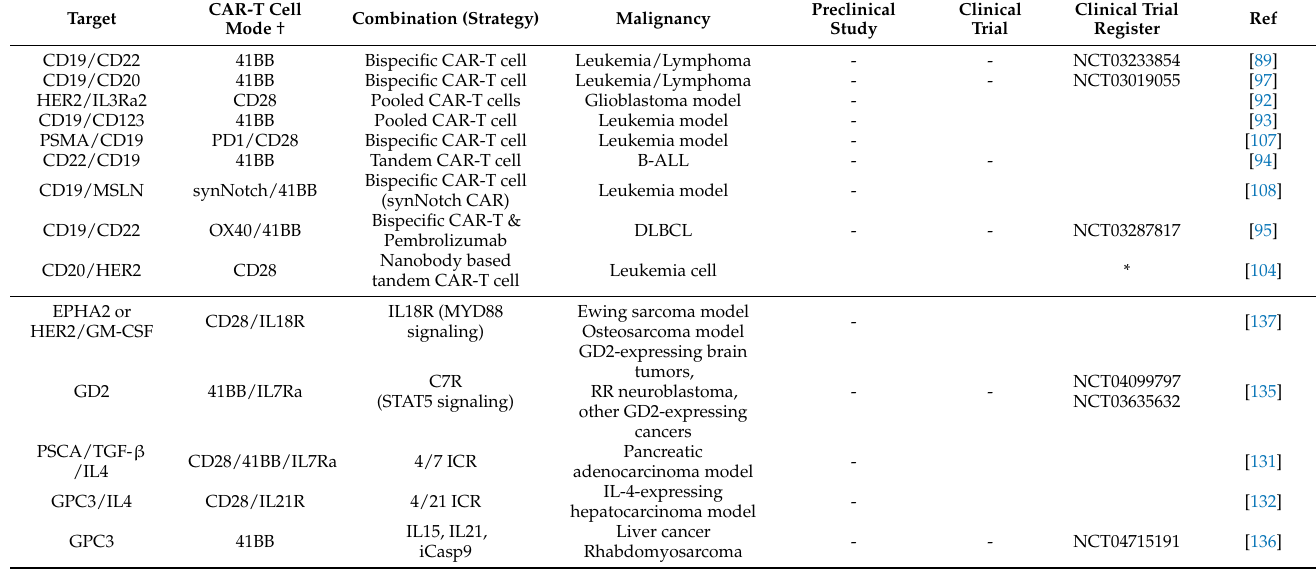
Table 1. Summary of novel strategies of CAR-T cell therapy described in Section 4, in combination with other CARs, genetically engineered T cells, chemotherapy, and immune checkpoint